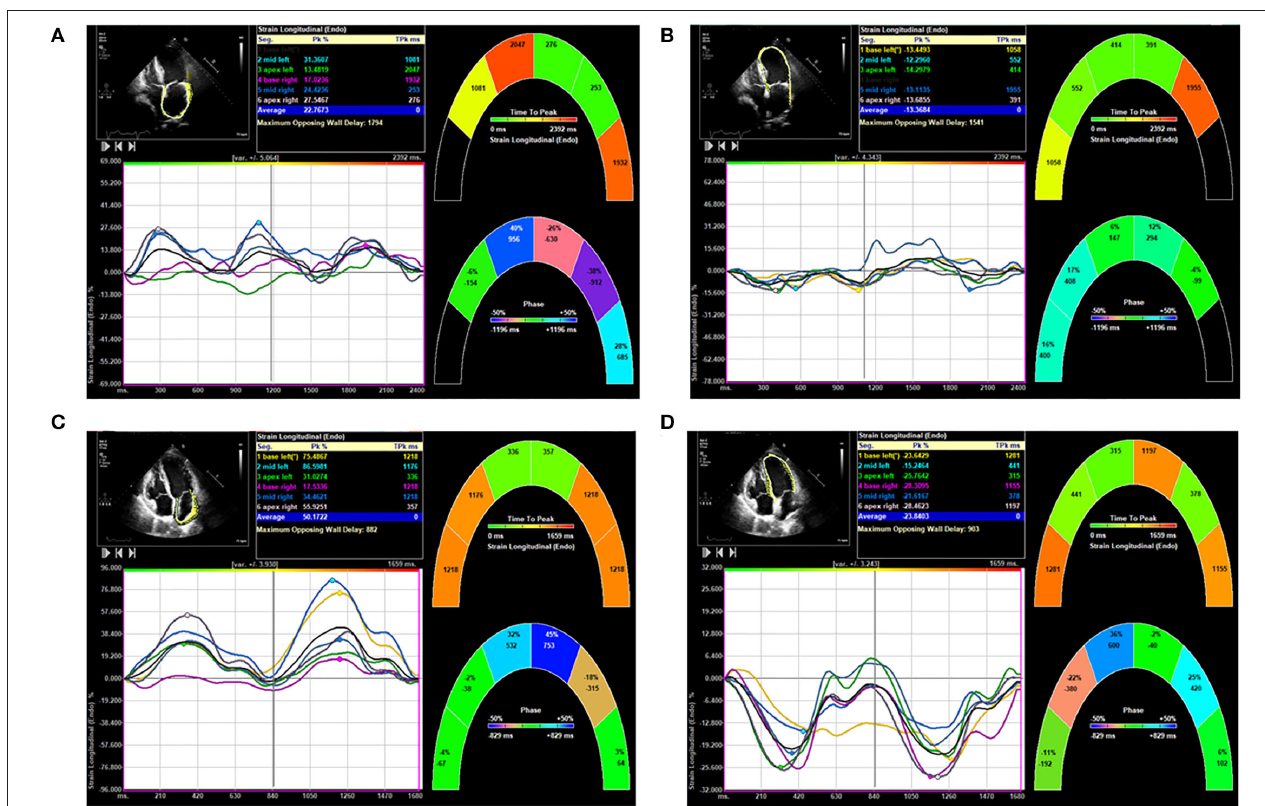
FIGURE 2 | Comparison of left atrial (LA) and left ventricular (LV) strain in patients from atrial fibrillation (AF) group and no-AF group. (A) Shows LA strain of a patient of the AF group. (B) Shows LV strain of the same patient of the AF group. (C) Shows LA strain of a patient of the no-AF group. (D) Shows LV strain of the same patient of the no-AF group.